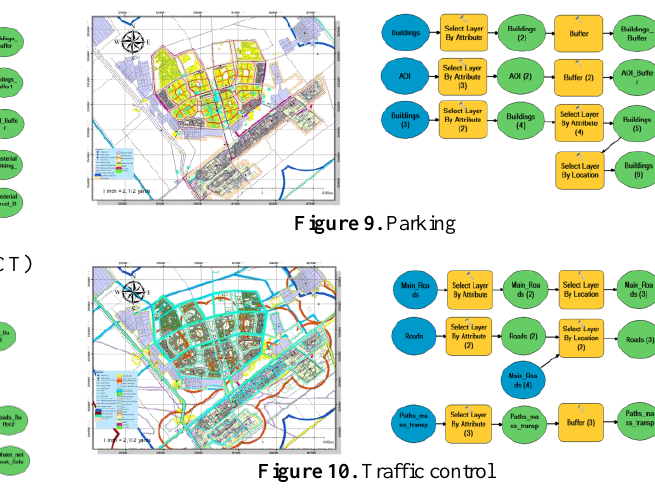
Figure 10. Traffic